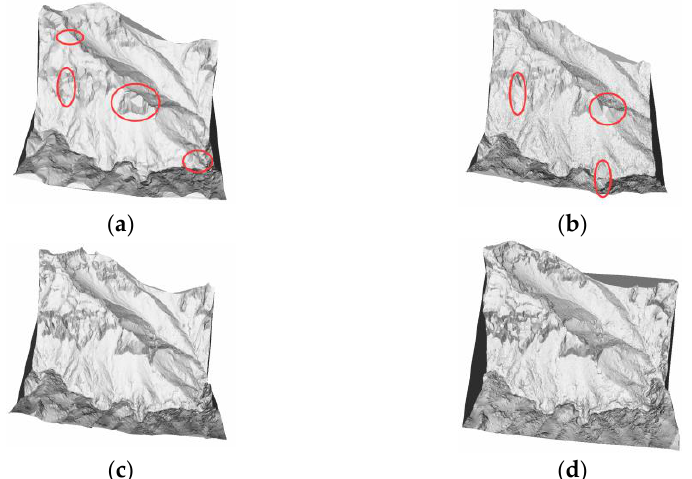
Figure 9. Filtered results of dataset I: ( a ) TerraSolid; ( b ) CSF; ( c ) proposed framework; ( d ) GroundTruth.